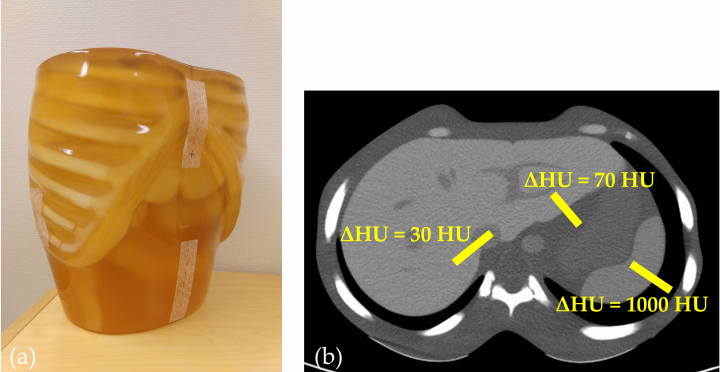
Figure 1. ( a ) Anthropomorphic abdomen phantom; ( b ) computed tomography (CT) image of the phantom illustrating the positions of the three edges used to measure noise profiles in the noise maps. The difference in tissue density over the three edges were 1000 HU, 70 HU and 30